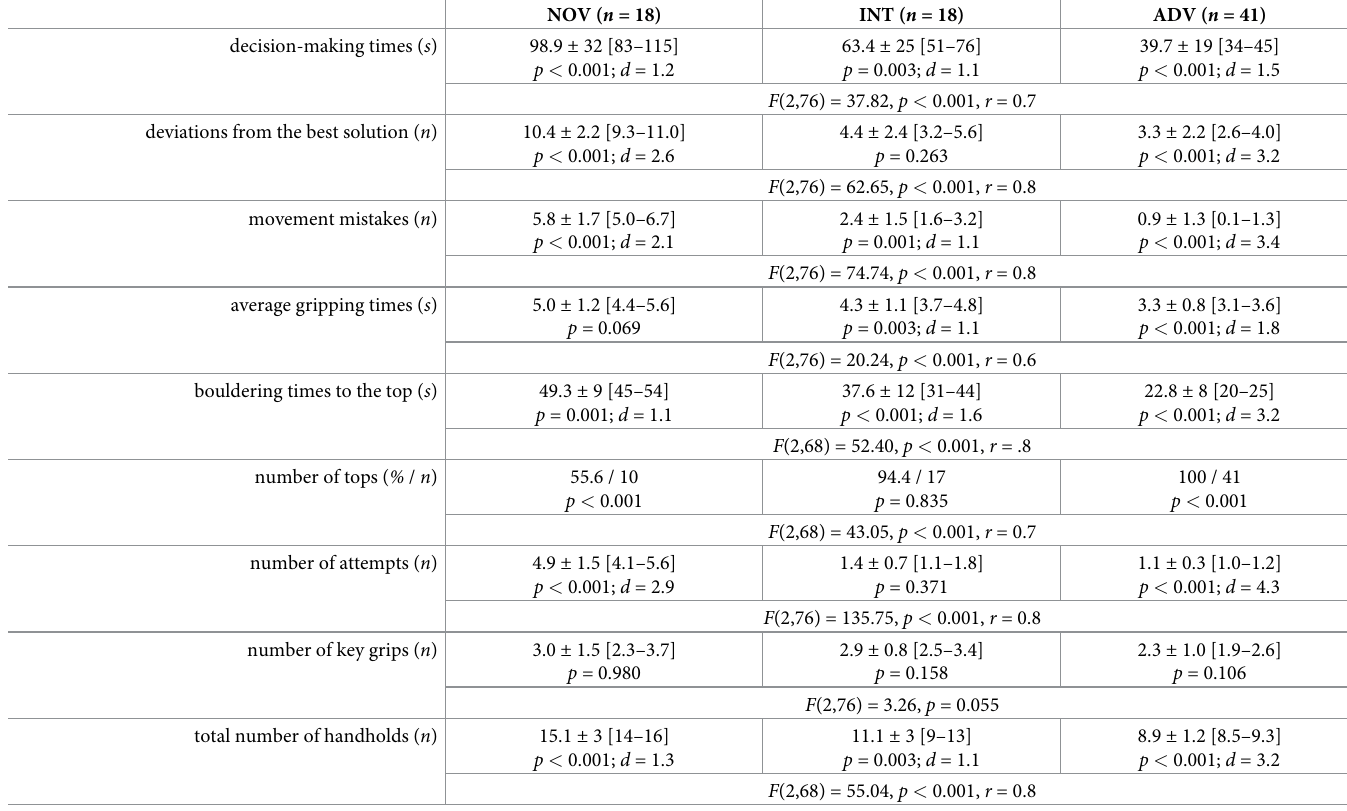
Table 4. Study results of the novice group (NOV), the intermediate group (INT), and the advanced group (ADV) in Experiment 3.